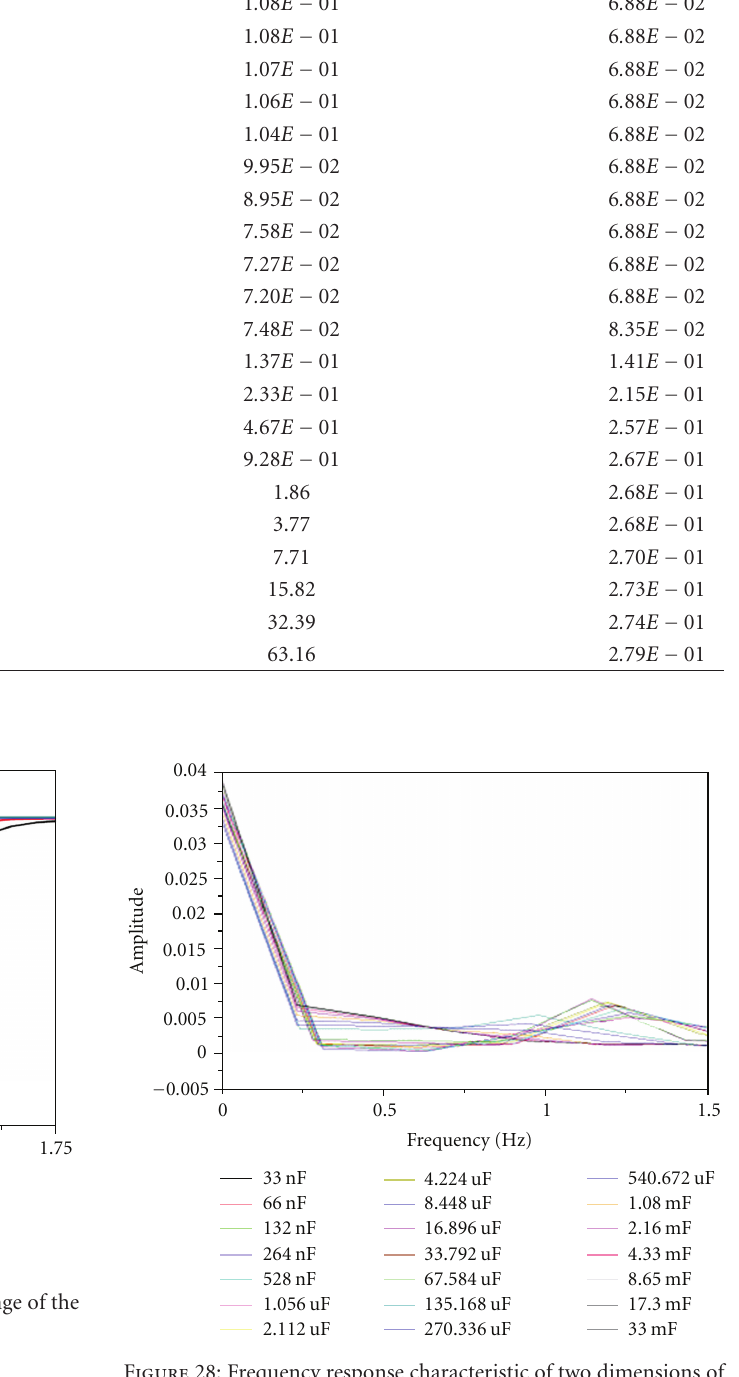
Figure 28: Frequency response characteristic of two dimensions of the pulse parameter for a change of the capacitance C 1